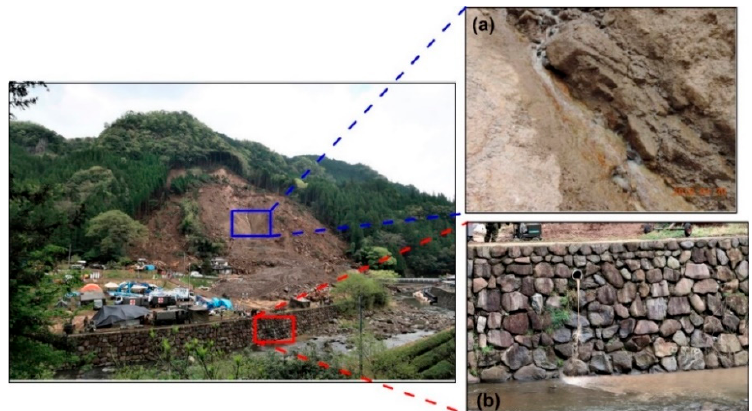
Figure 8. Water outflow was observed at different locations of the landslide. ( a ) The water outflow at the main body of the landslide. ( b ) The water outflow near the landslide toe.